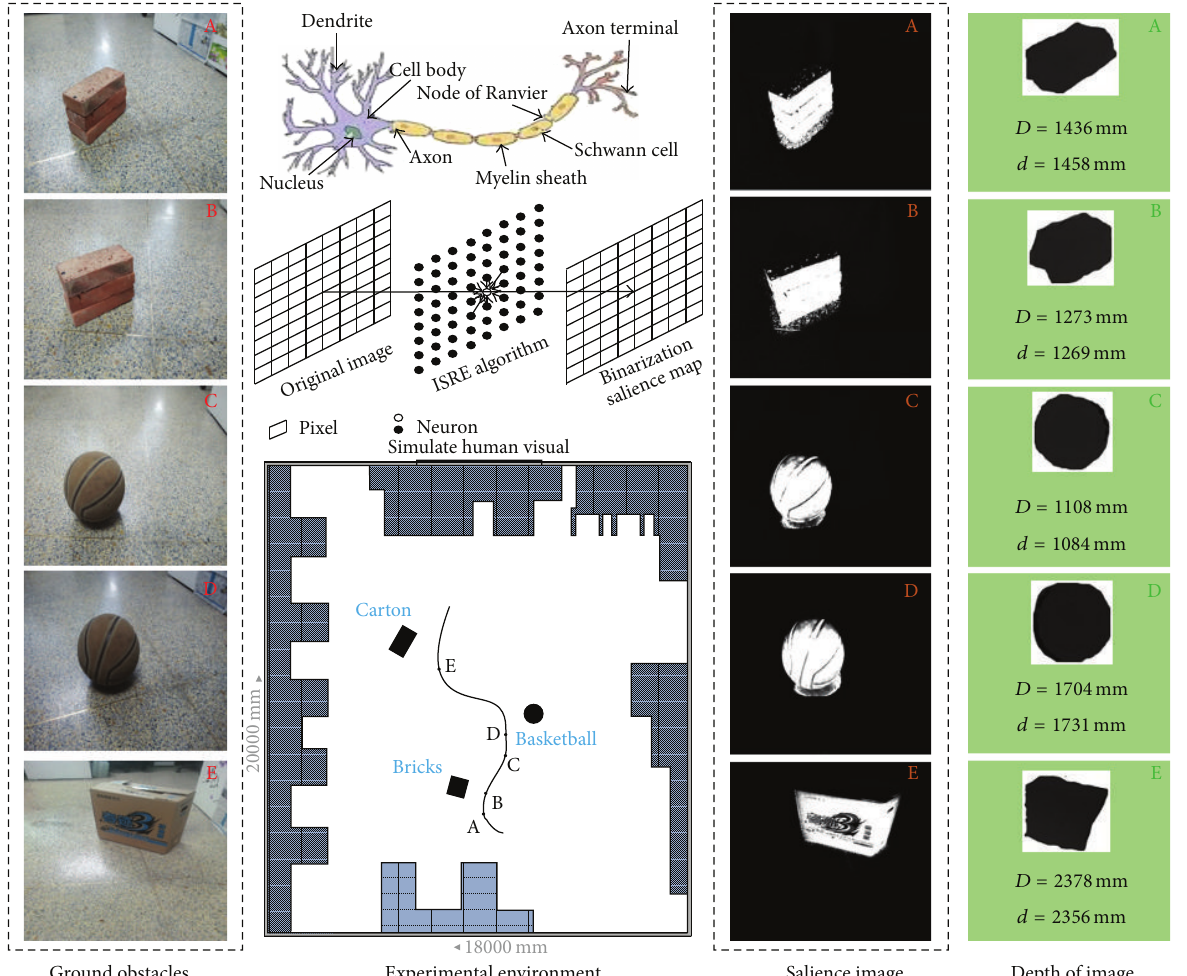
Figure 8: Experiment results of real world images with our